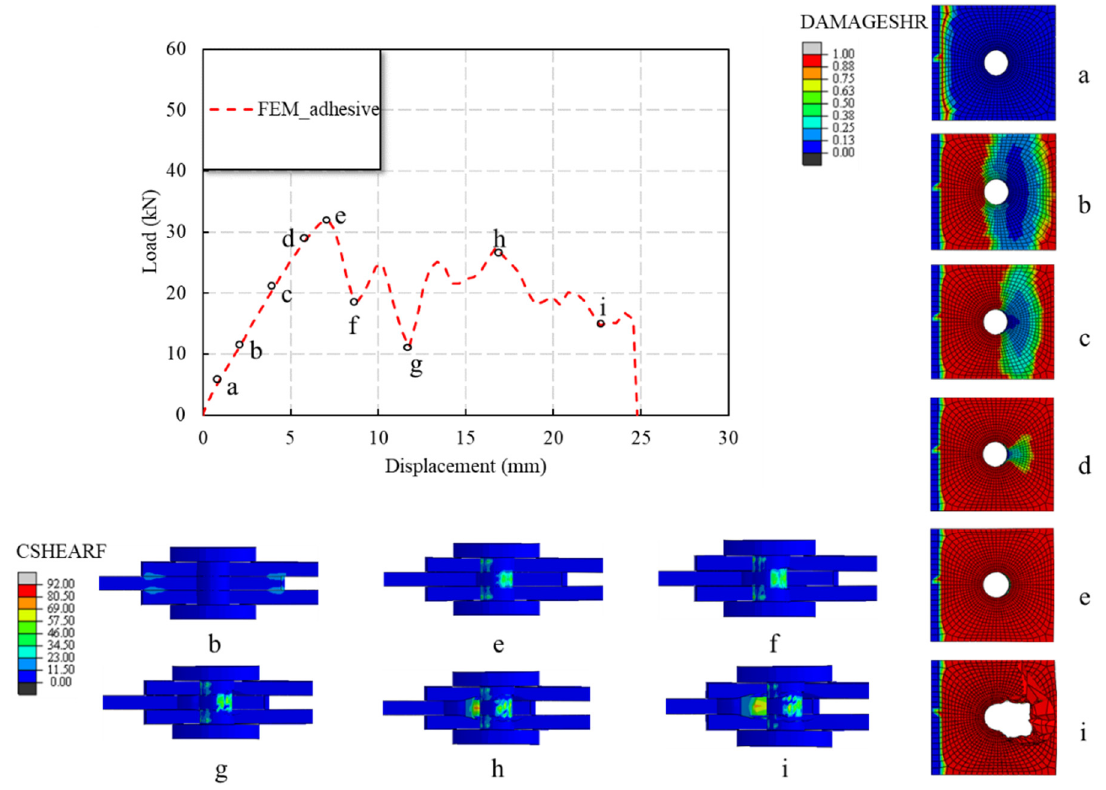
Figure 16. Progressive failure of the bolted–bonded hybrid connection specimen .